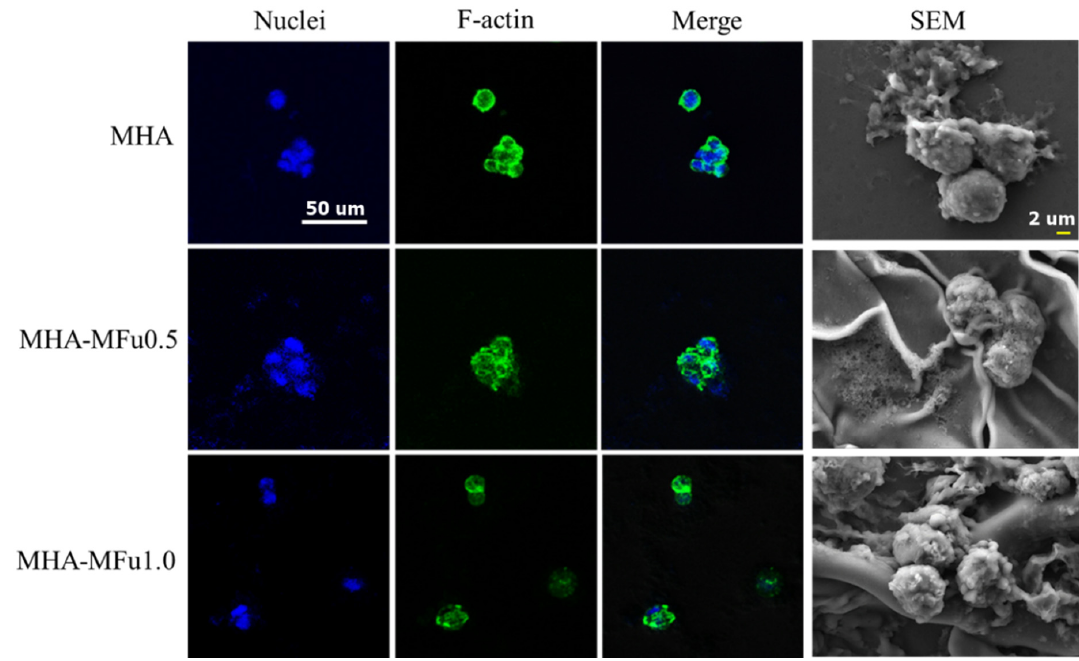
Figure 7. Immunofluorescence and SEM analysis of cell morphology on the MHA and MHA-MFu hydrogels after 7 days. MG63 osteoblasts were stained with F-actin (green), and cell nuclei were stained with DAPI (blue). Scale bar = 50 μ m for immunofluorescence images and 2 μ m for SEM images.